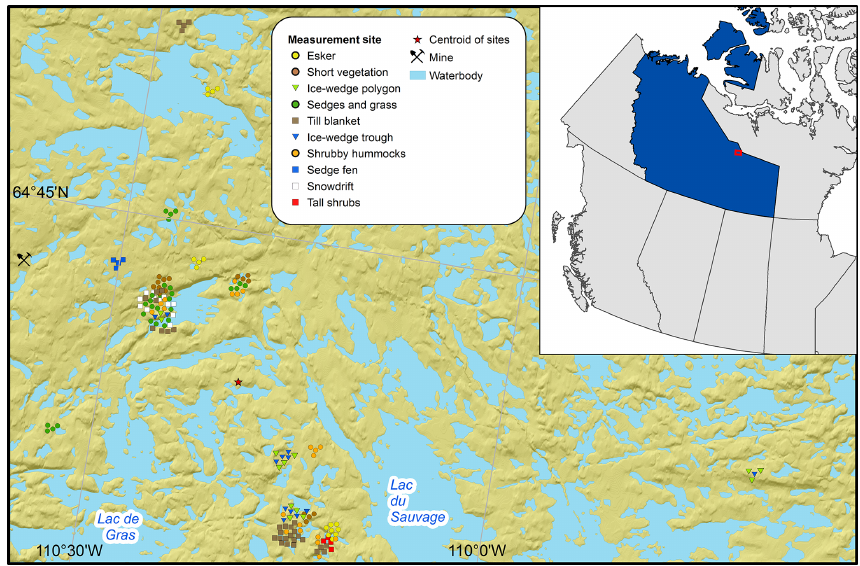
Figure 4. Study area and approximate location of measurement sites. Many point locations overlap at the scale of the map, so the positions of their markers have been dispersed to better illustrate the number and type of sites. The centroid of all measurement sites (red star) was used as the location for which GlobSim reanalysis data were derived. The top right inset map shows the location of the study area (red square) within the Northwest Territories (blue region) of Canada. The elevation tinted hillshade basemap is provided by the Natural Resources Canada Federal Geospatial Platform Elevation Data Web Mapping Service and is derived from the Canadian Digital Elevation Model (CDEM). Water-body outlines were obtained from the ArcGIS online data